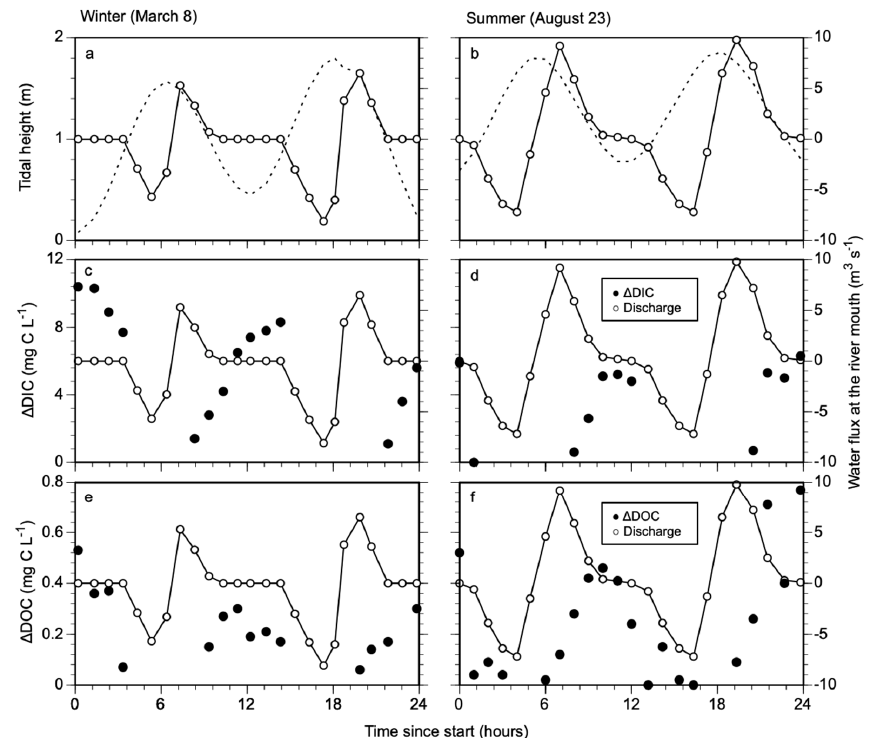
Figure 6. Tidal variations of water fluxes ( a , b ), Δ DIC ( c , d ), and Δ DOC ( e , f ) concentrations at the river mouth in a small estuarine mangrove during the time course. The broken line indicates the tidal height (m) obtained from the Japan Meteorological Agency. The solid line with open circles indicates the water fluxes (discharge) at the river mouth, the positive values denote the water flow from mangrove to the sea, and the negative values denote the water flow from the sea to the mangrove. The filled circles indicate Δ DIC and Δ DOC, which represent mangrove-derived carbon.